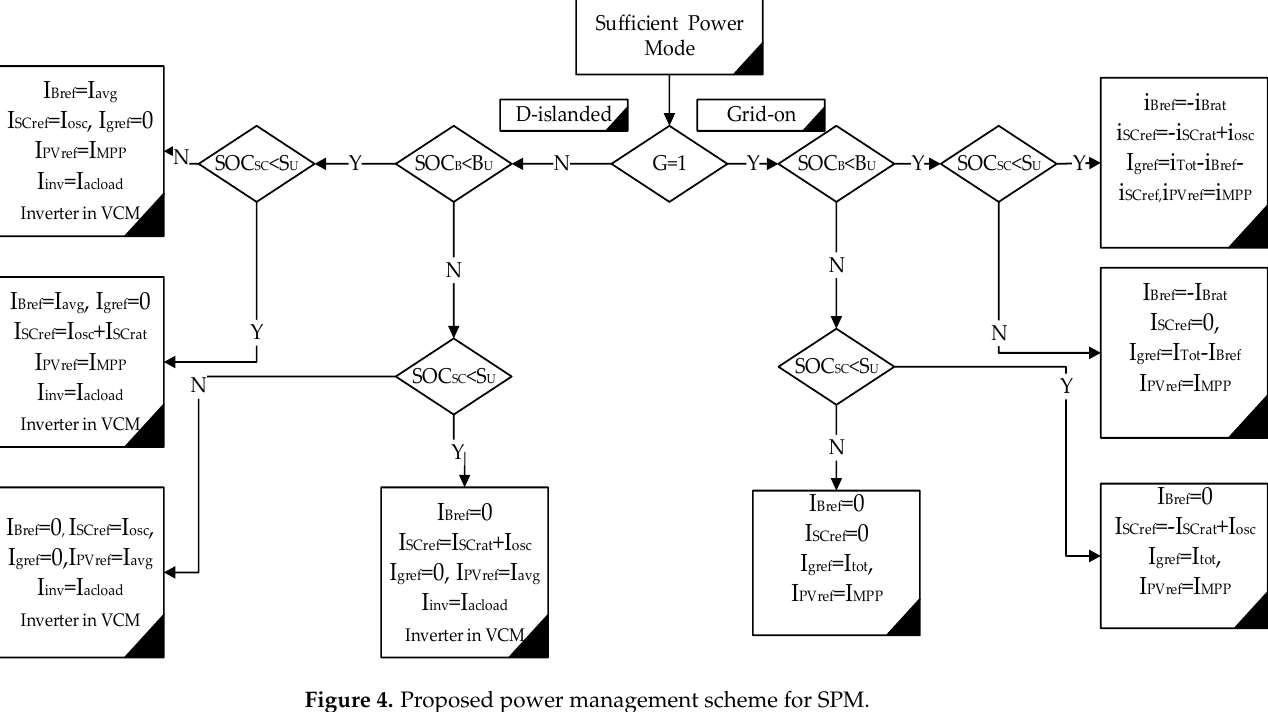
Figure 4. Proposed power management scheme for SPM.